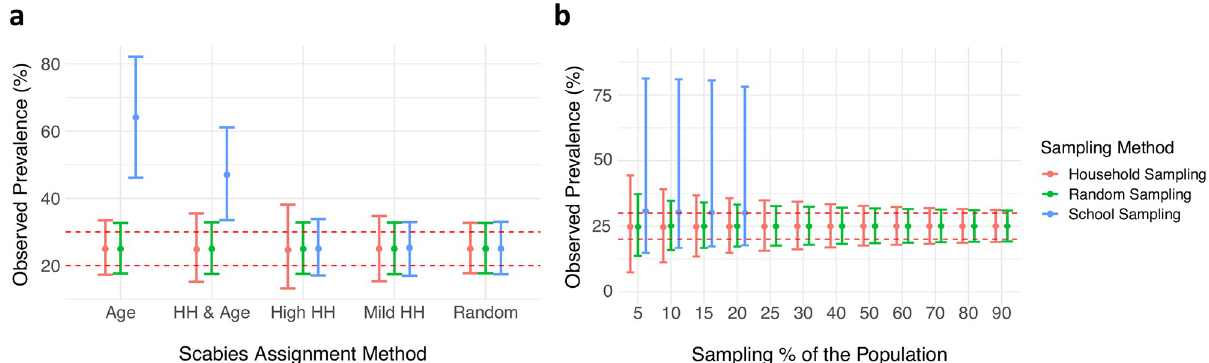
Fig 6. Observed scabies prevalence in samples selected using. different (a) assignment methods and (B) sampling percentages. The results (median and 2.5% to 97.5% quantiles) are plotted for an exemplar input prevalence percentage between 20–30% across all population sizes with a sampling percentage between 20–30%. Red dashed lines represent 20% and 30% prevalence. Additional results with differing input prevalence and differing population sizes are presented in S2, S3 and S4 Figs. In panel B, the highest sampling percentages could not be achieved in the school-based sampling strategy due to insufficient population size in the school aged group.